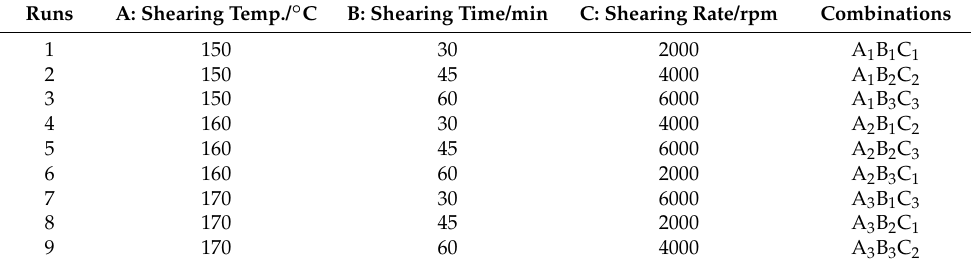
Table 4. OATS Design.